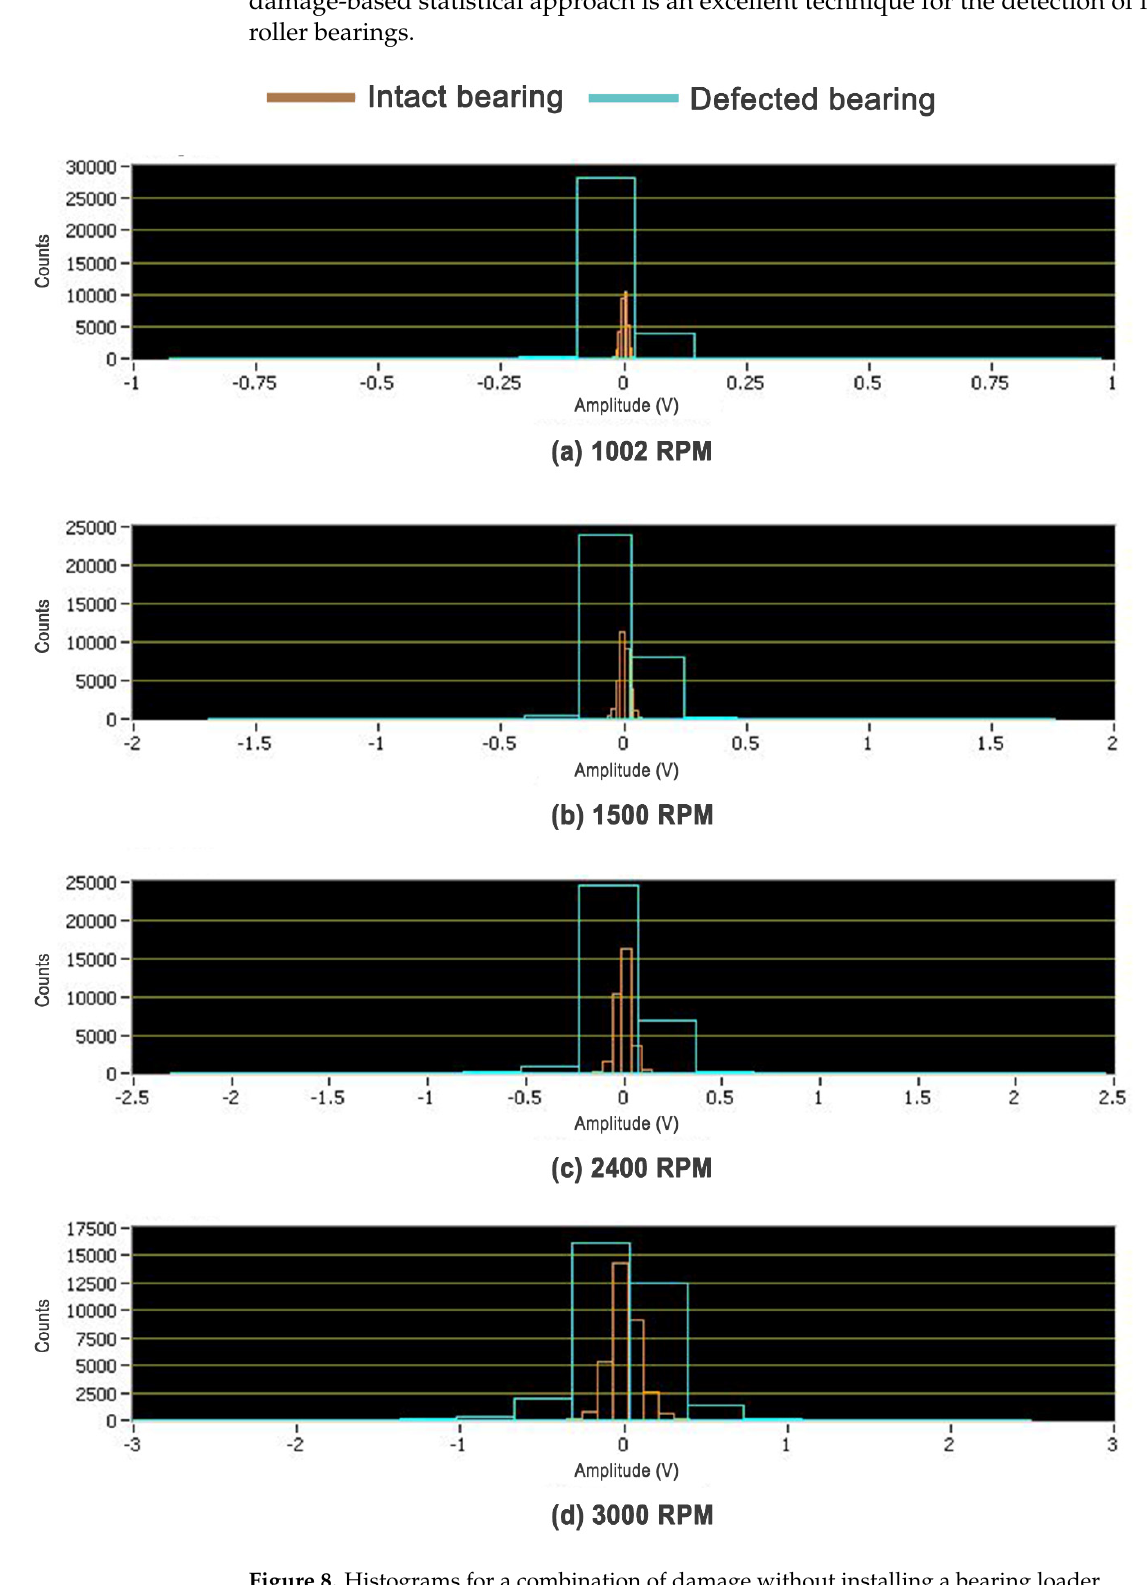
Figure 8. Histograms for a combination of damage without installing a bearing loader.